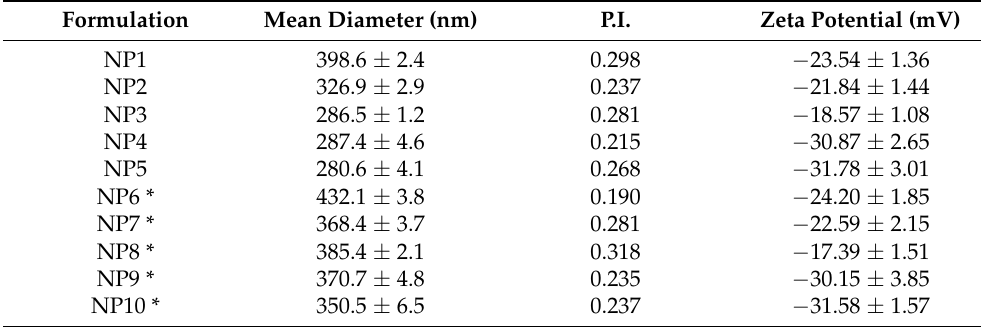
Table 2. Mean diameters, polydispersity indexes, and Zeta potentials of blank nanoparticles